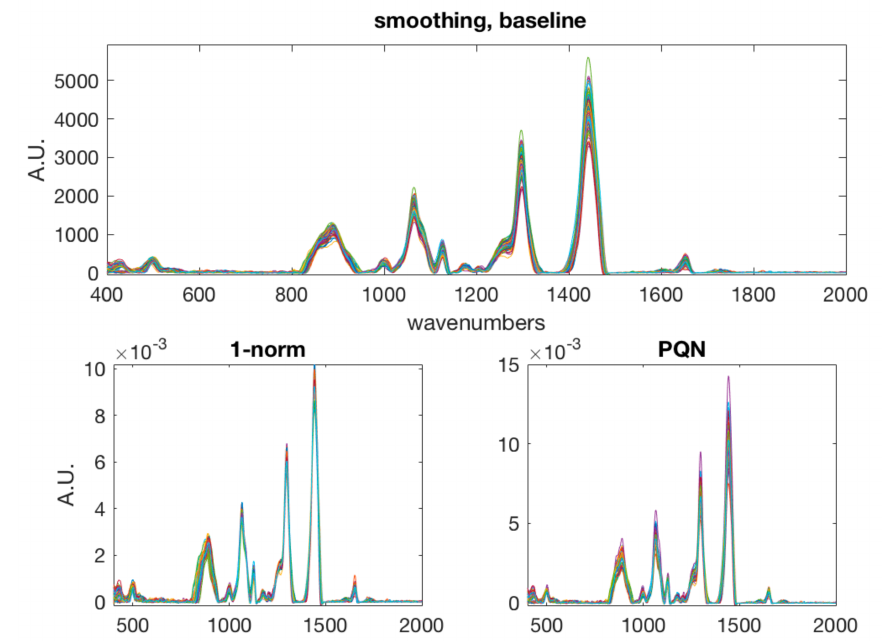
Figure 2. Aligned spectra after smoothing and baseline correction ( top ), normalization to unit area ( bottom left ) and probabilistic quotient normalization ( bottom right